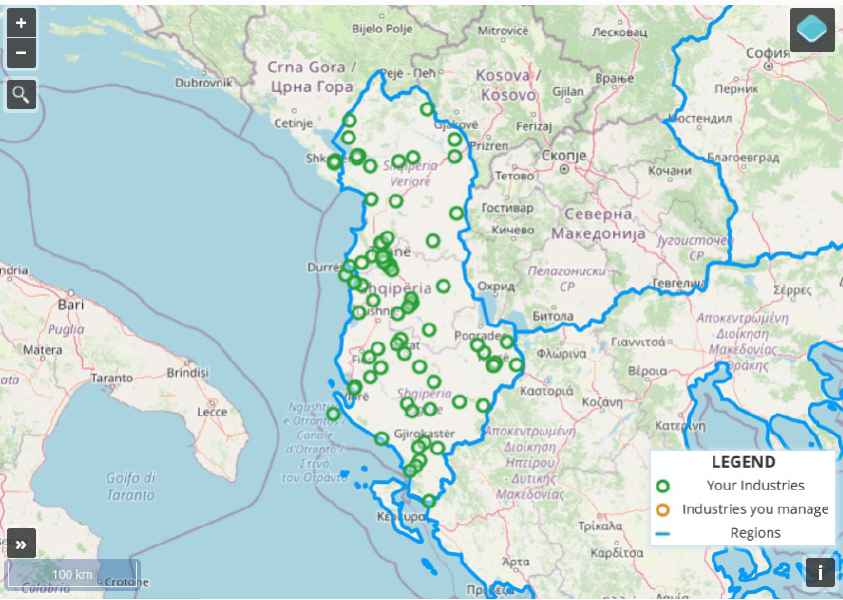
Figure 1. Map of Albanian participants (screenshot from www.swanplatform.eu, accessed on 10 May 2022).